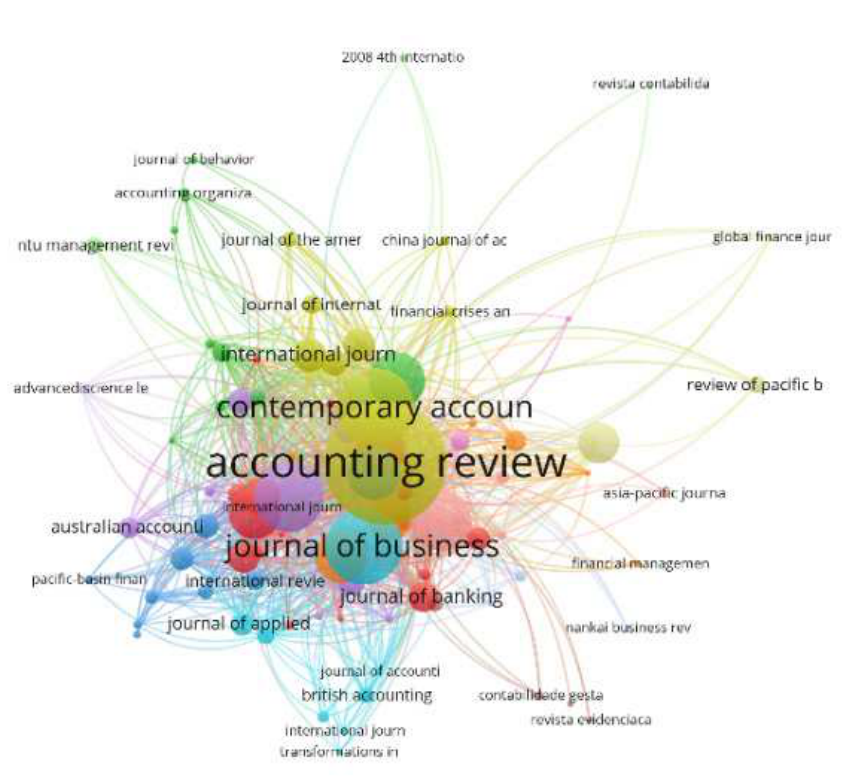
Figure 7. A science map of sources with the highest number of publications with the term “Earnings Management” from 1900 to